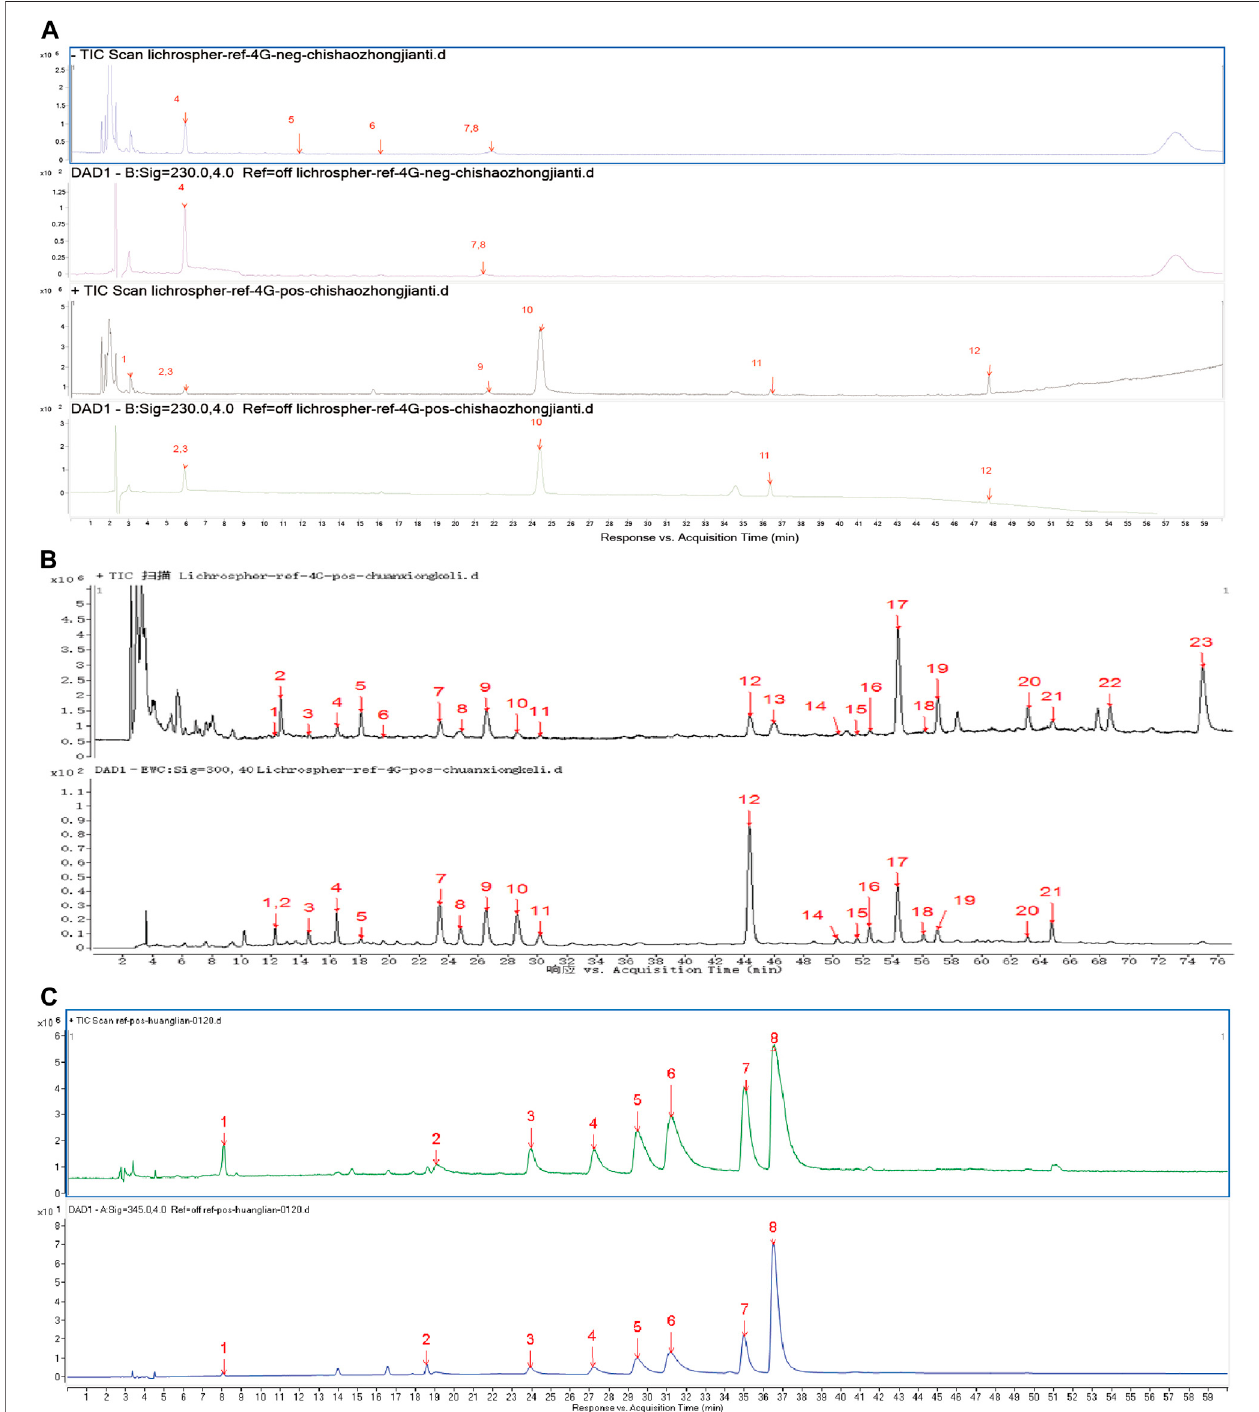
FIGURE5| ThecomponentsofHJFidenti fi edfromUPLC-Q-TOF/MS. (A) ,Twelvecomponentsidenti fi edin RadixPaeoniaeRubra :8-debenzoylpaeoni fl orin,gallic acid, 1-O- β -D-glucopyranosyl-paeonisuffrone, galloylsucrose, mudanpioside F, anthocyanidin B7, oxypaeoni fl orin, cianidanol, albi fl orin, paeonio fl orin, pentagalloylglucose and 4 ″ -hydroxy-6 ′ -benzoylpaeoni fl orin; (B) , twenty-three components identi fi ed in Ligusticum wallichii : 5-hydroxymethylfurfural, phenylalanine, isomer of chlorogenic acid, neochlorogenic acid, tryptophan, p -hydroxybenzoic acid, chlorogenic acid, cryptochlorogenic acid, isovanillic acid, caffeic acid, cynarin,ferulicacid,senkyunolideJ,cis-1,5-dicaffeoylquinicacid,isochlorogenicacidB,isochlorogenicacidA,senkyunolideI,isochlorogenicacidC,senkyunolideH,3- butylidenephthalide, proantho cyanidins, senkyunolide G and senkyunolide A; (C) , eight components identi fi ed in Rhizoma coptidiswas : magno fl orine, groenlandicine, columbamine, jatrorrhizine, epiberberine, coptisine, palmatine and berberine.